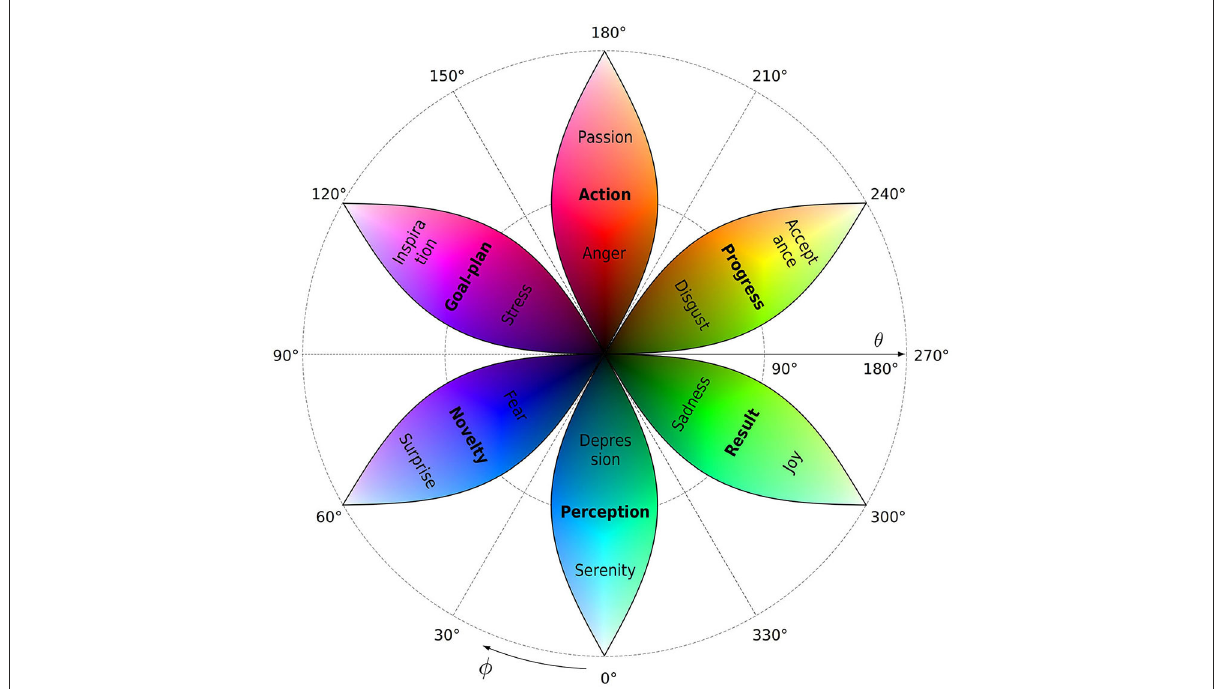
FIGURE7 Color-emotion map of the qubit semantic space in the planar layout of the Bloch sphere. The leaves are centered at the main chromatic colors used above. Each leaf is the corresponding area-preserving part of the color map shown in Figure 6. The polar angle increases outwards, such that the South pole 0 is mapped to the center θ 0, while the North pole 1 locates at the outer circle θ 180 ◦ . Process stages (bold), the | i | i = = corresponding positive and negative emotional prototypes locate in the middles, inner ( θ < 90 ◦ ), and outer ( θ > 90 ◦ ) parts of the leaves according to Figure 3 and Table